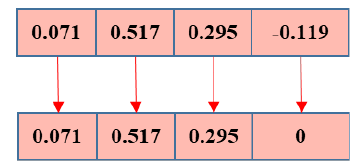
Fig. 4 ReLU activation function of max-pooling